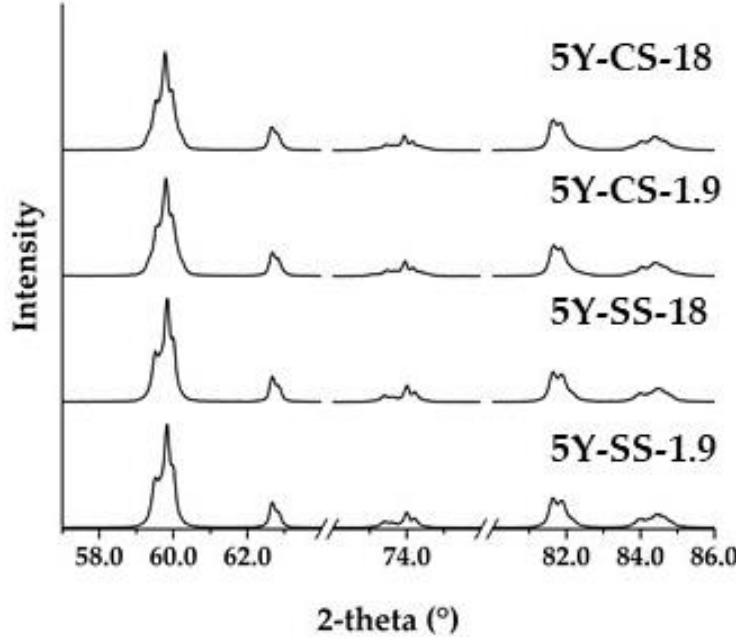
Figure 5. X-ray diffraction patterns of 5Y-SS-1.9, 18 and 5Y-CS-1.9, 18.